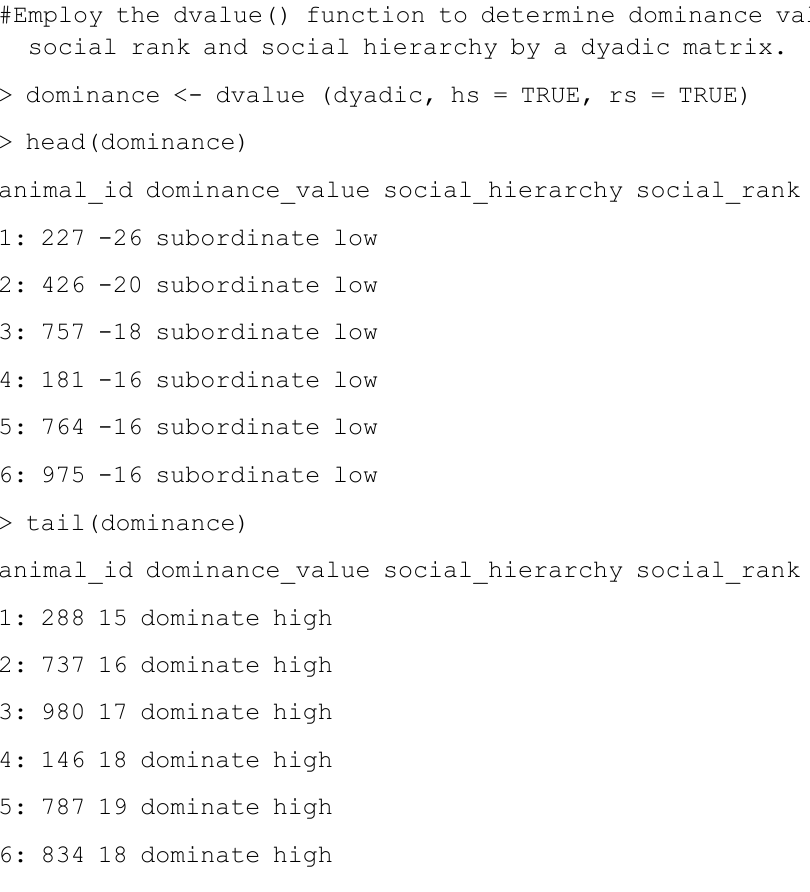
Visualization of the results. To visualize the results, the package provides functions based on the “ggplot2” [25] and “circlize” [26] packages. The barDom() function returns